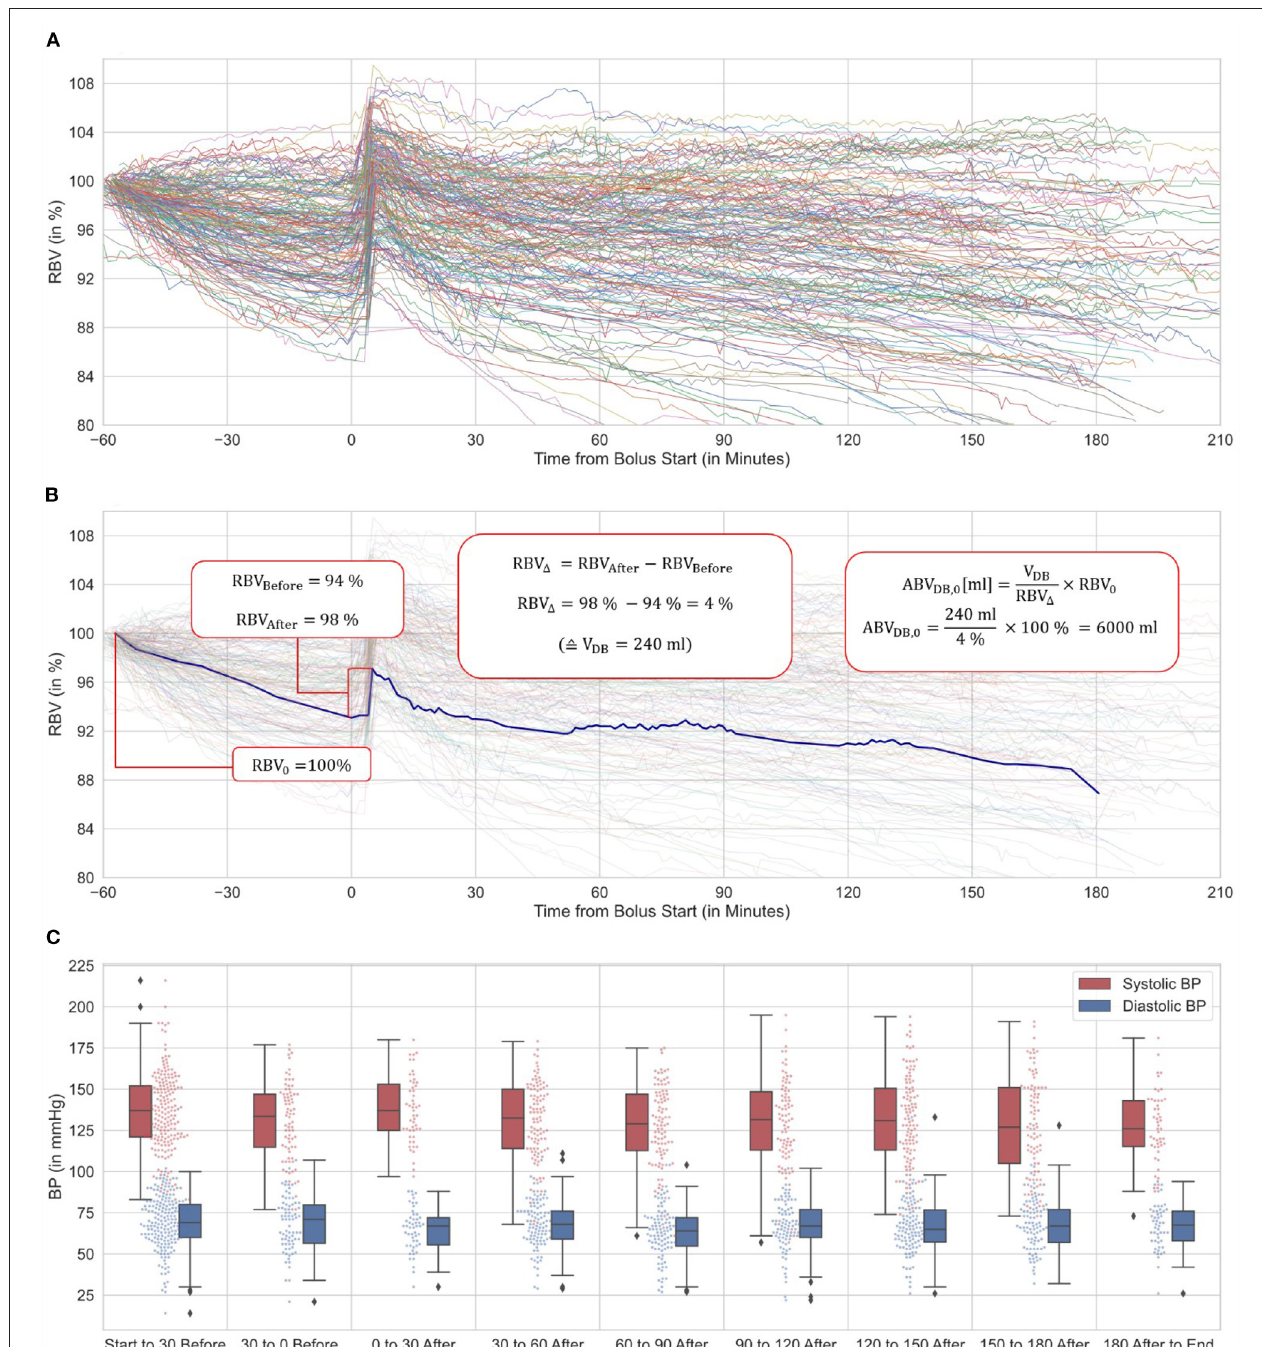
FIGURE 2 | BVM-curve variation, ABV-DB calculation details and blood pressure (based on 86 patients, 186 sessions). (A) 186 RBV curves showing significant divergence in curve morphology and individual progression after bolus administration. (B) Examplary RBV curve and ABV-DB calculation using dialysate bolus method. (C) Systolic and diastolic blood pressure over time relative to the dialysate bolus are depicted in box-and-whisker and jitter plots. BPs during the bolus application are omitted.